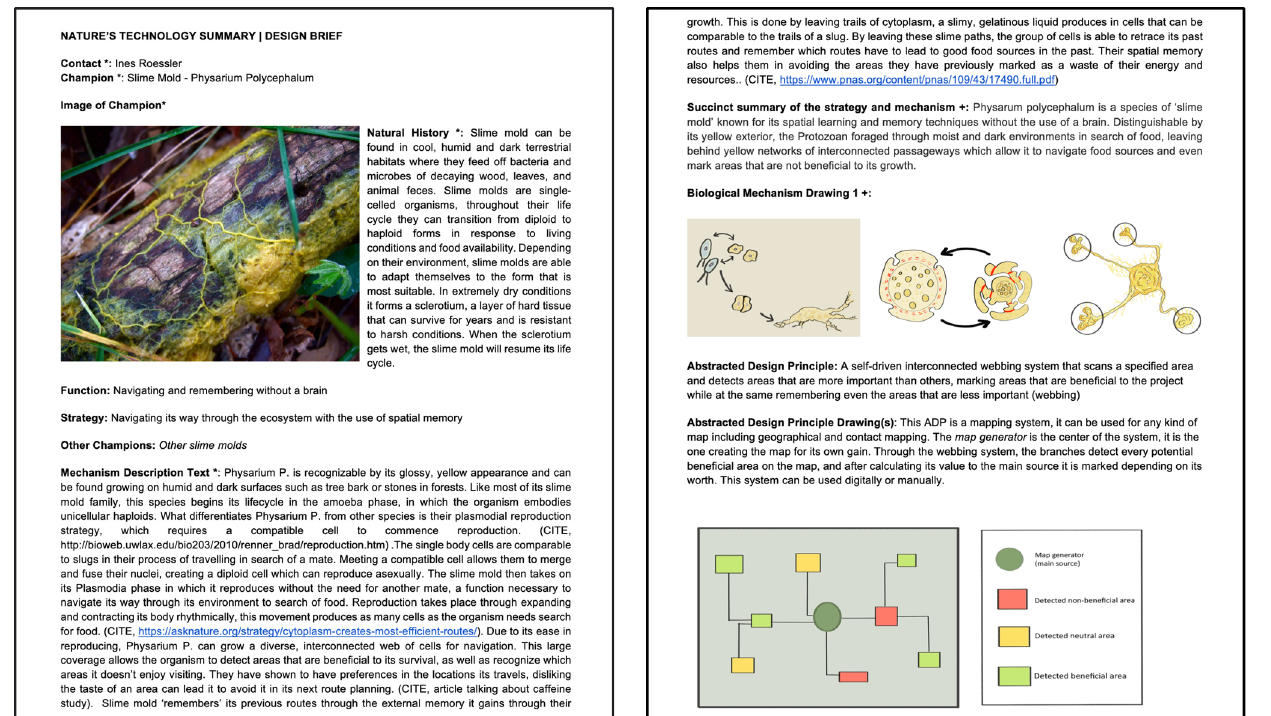
Figure 5. Example of a Nature Technology Summary (NTS). I. Rössler and C.Whitehead, 2021.